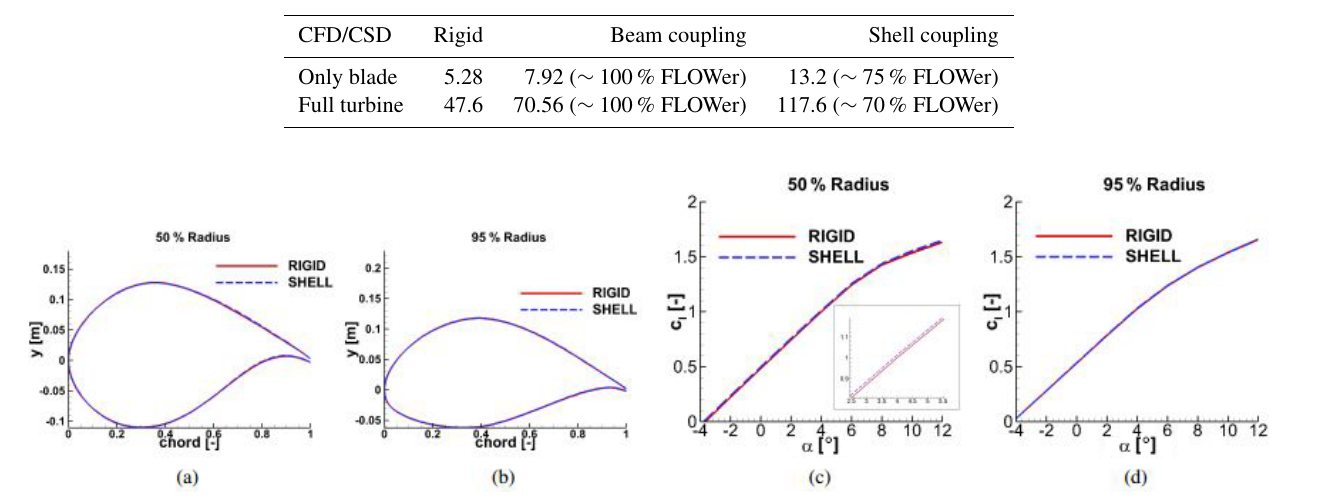
Figure 7. Blade sections enlarged in the y direction and c l calculations for r/R = 50% and r/R =